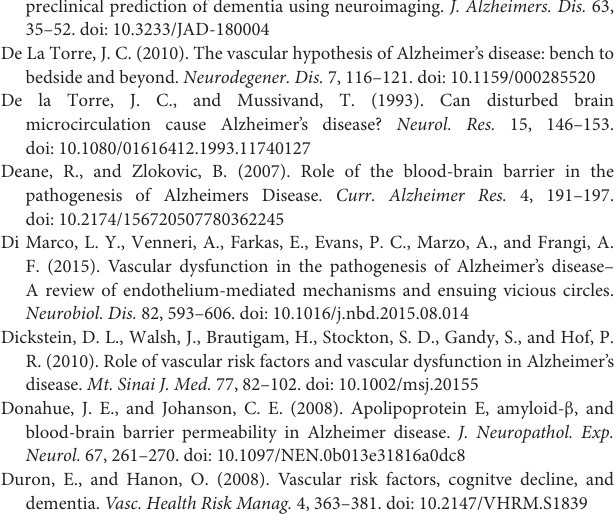
Supplementary Table 3 | List of significantly regulated proteins in the cerebrovasculature of the inferior frontal gyrus in high CAA [AD] vs. age-matched control cases. Data are expressed as the negative Log10 of the p -value (green horizontal bars–significance cut off set at > 1.3), and the Log2 fold change between high CAA [AD] vs. age-matched control cases. Heat map indicates downregulated (Red box) or upregulated (Blue box) proteins. Statistical analyses was performed using t-test after logarithmic transformation. Red text highlights indicate 155 significantly proteins identified that were unique to only this comparison in our entire study . Supplementary Table 4 | List of significantly regulated proteins in the cerebrovasculature of the inferior frontal gyrus in low vs. high CAA [AD] cases. Data are expressed as the negative Log10 of the p value (green horizontal bars–significance cut off set at > 1.3), and the Log2 fold change between low vs. high CAA [AD] cases. Heat map indicates downregulated (Red box) or upregulated (Blue box) proteins. Statistical analyses was performed using t-test after logarithmic transformation. Red text highlights indicate 36 significantly proteins identified that were unique to only this comparison in our entire study